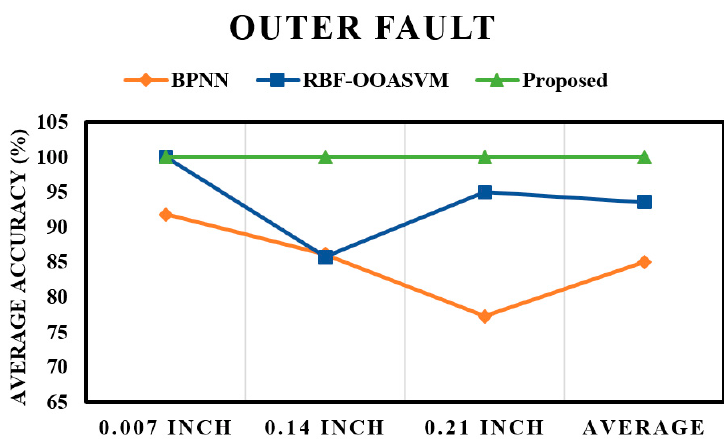
Figure 10. Fault severity prediction in an outer fault.